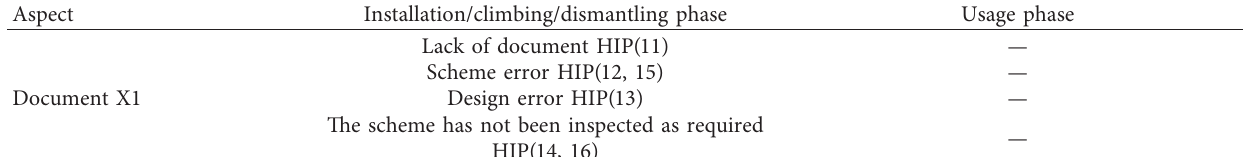
Table 11: Integration of